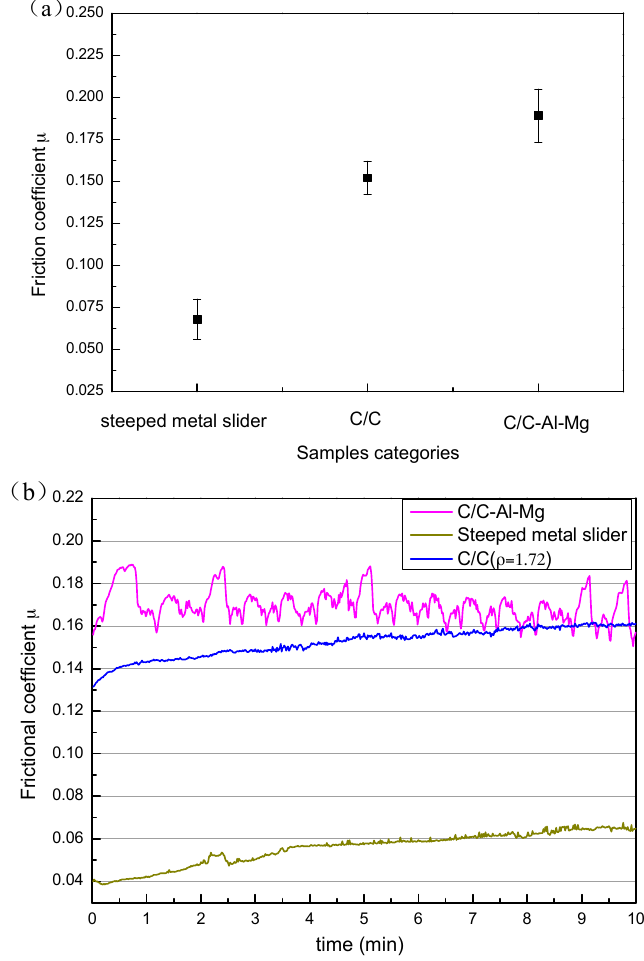
Figure 7. Friction coefficients for different samples. ( a ) Friction coefficient; ( b ) Friction force curve.